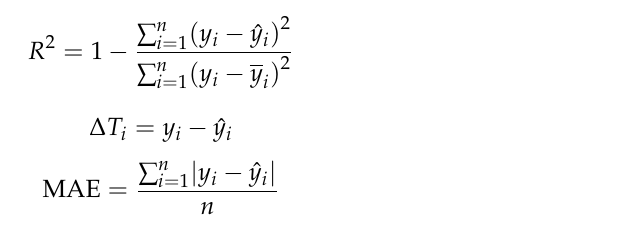
where y i , ˆ y i , and y are experimental data, predicted data, and the mean value of experi- i mental data, respectively. The training data at B1M are fitted well by the C1M-B1M model, with an R 2 value of 0.993. The validation result of the C1M-B1M model is shown in Figure 6. The experimental data of B2M agree well with the predicted data, with an MAE value of 0.38 K. ∆ T can be controlled within about ± 1 K. Therefore, good accuracy is obtained by the C1M-B1M model under the initial temperature of 35 ◦ C and flow rate of 770 mL/min.